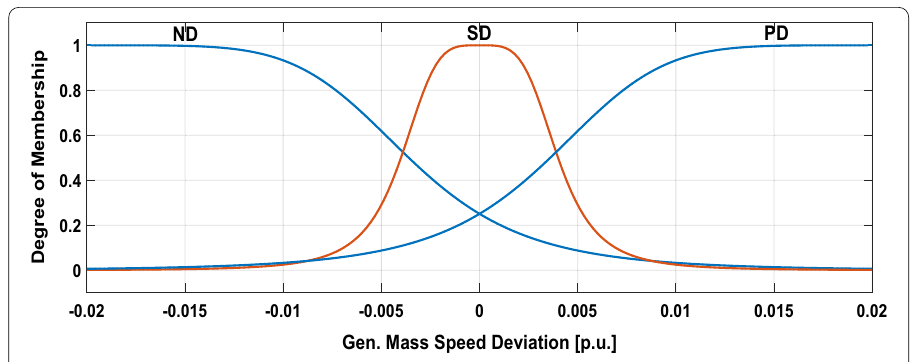
Fig. 6 Membership functions of the FLC